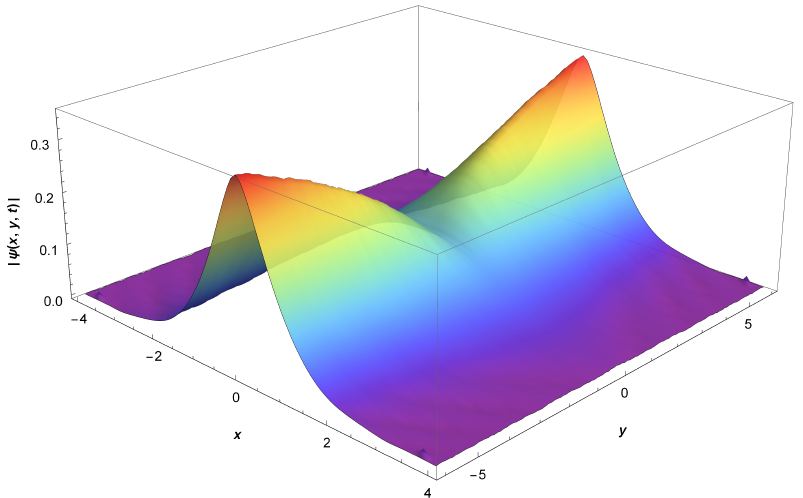
Figure 2. Profile of | Ψ ( x , y , t ) | for η x = 1/2. For illustrative purposes, we consider ¯ ht / ( 2 m ) = 1, l = 1 and the initial condition ϕ ( x ) = δ ( x ) δ ( y ) .